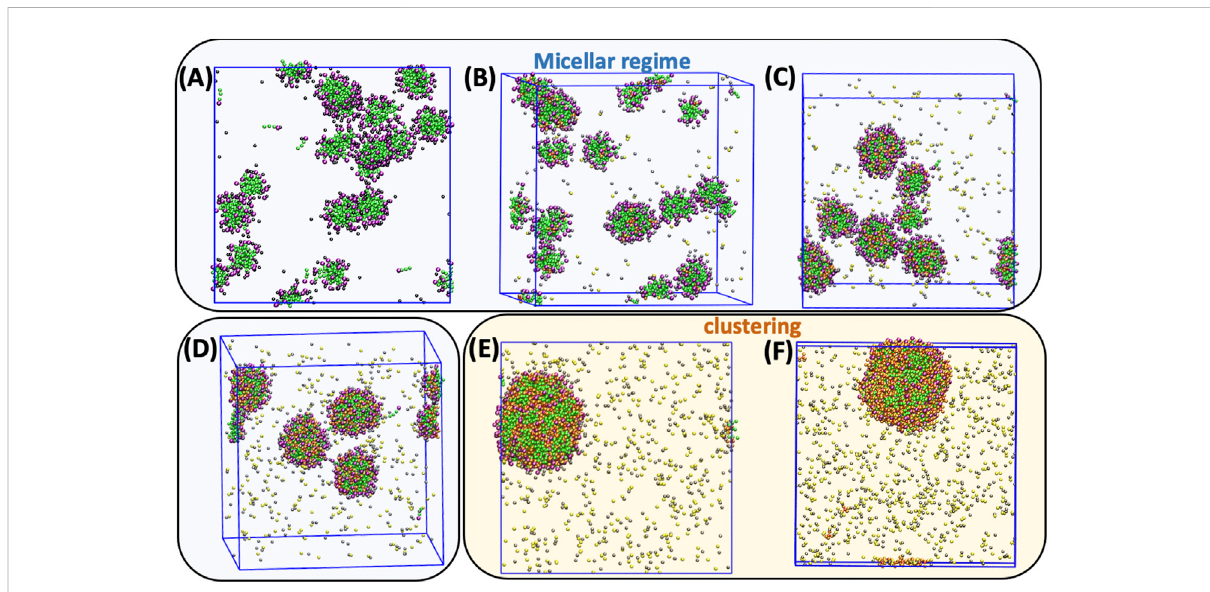
FIGURE 2 CG-MD simulation snapshots after for 2.5 μ s for (A) 0.0, (B) 0.1 and (C) 0.3, (D) 0.5, (E) 0.7 and (F) 1.0 [N 4,4,4,4 ] + /[DS] - molar ratios in a 2 wt% of SDS aqueous solution at 298 K. The color code is as follows: SDS alkyl tails and Sulphur charged headgroups are colored in green and purple, respectively. Chlorides are yellow, sodium grey, [N 4,4,4,4 ] + butyl groups orange, and the ammonium centers are red whilst the dummy beads and water were not represented for clarity.